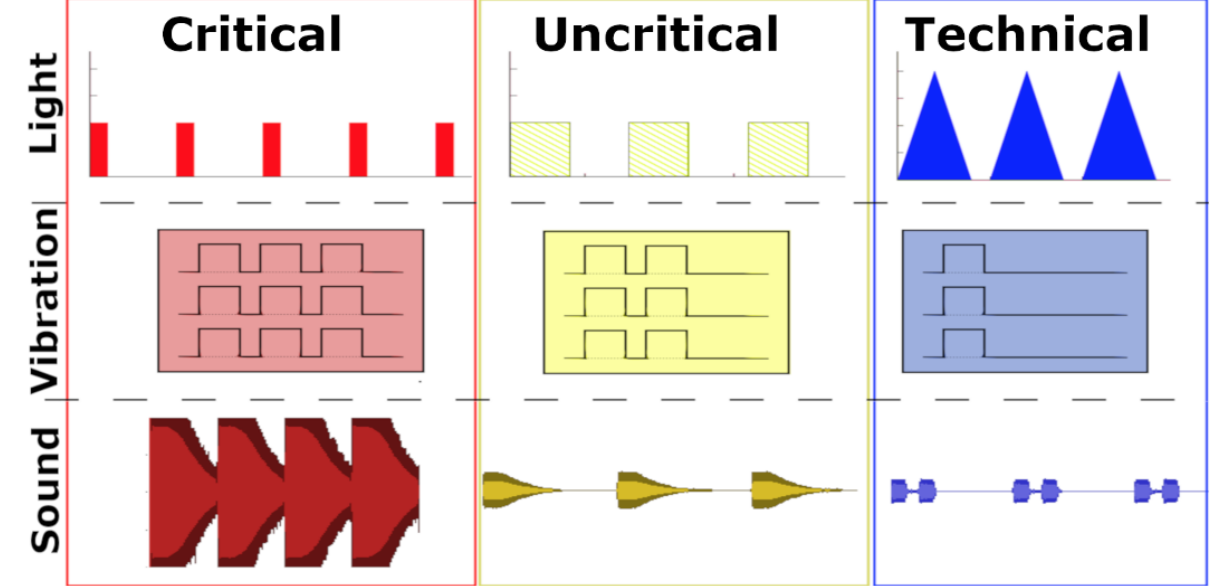
Figure 21. Lights, vibration, and sound patterns generated by the “peripheral light, tactile, and auditory” displays, respectively by Cobus and Heuten